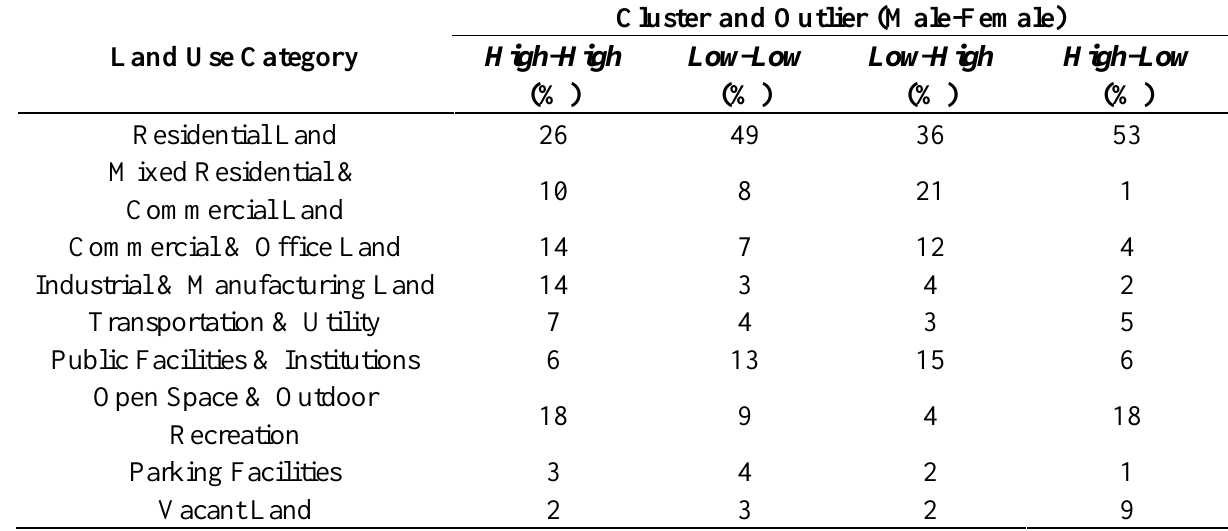
Table 3. Percentages of land use categories within clusters and